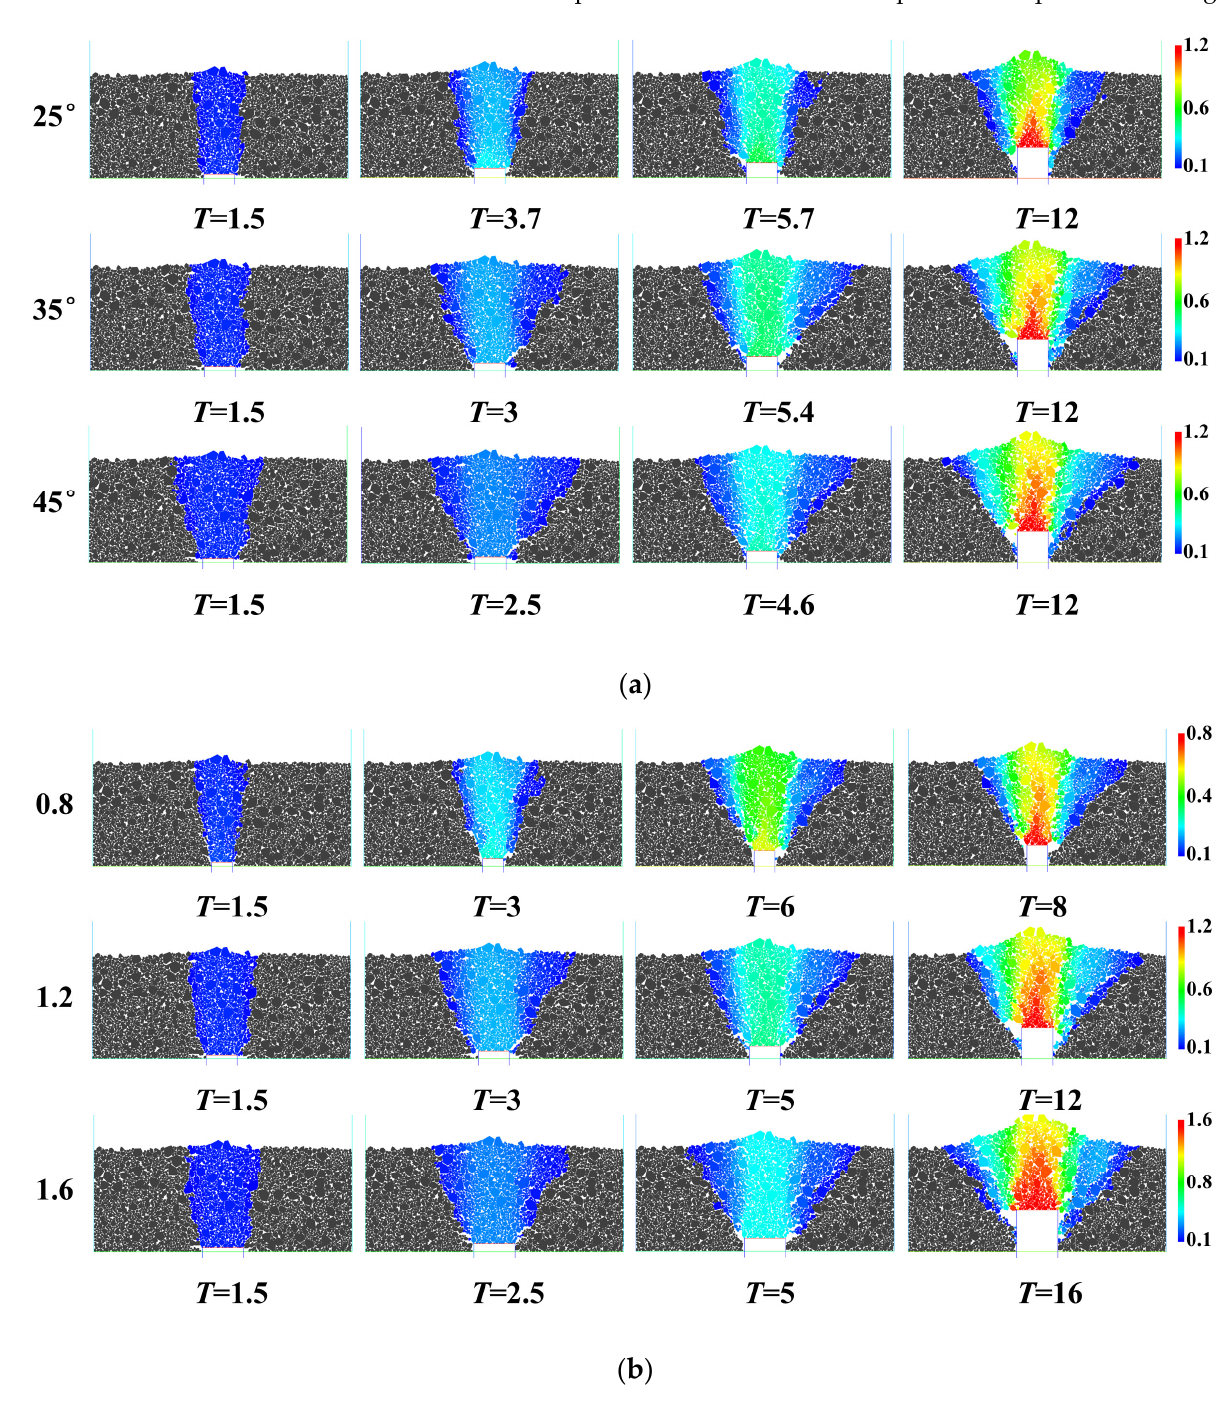
Figure 6. Displacement change in expansion process under different working conditions: ( a ) the expansion process of the collapse body with different internal friction angles when the expansion size is 1.2 m; ( b ) the expansion process of the collapse body with different expansion sizes when the internal friction angle is 37.5 ◦